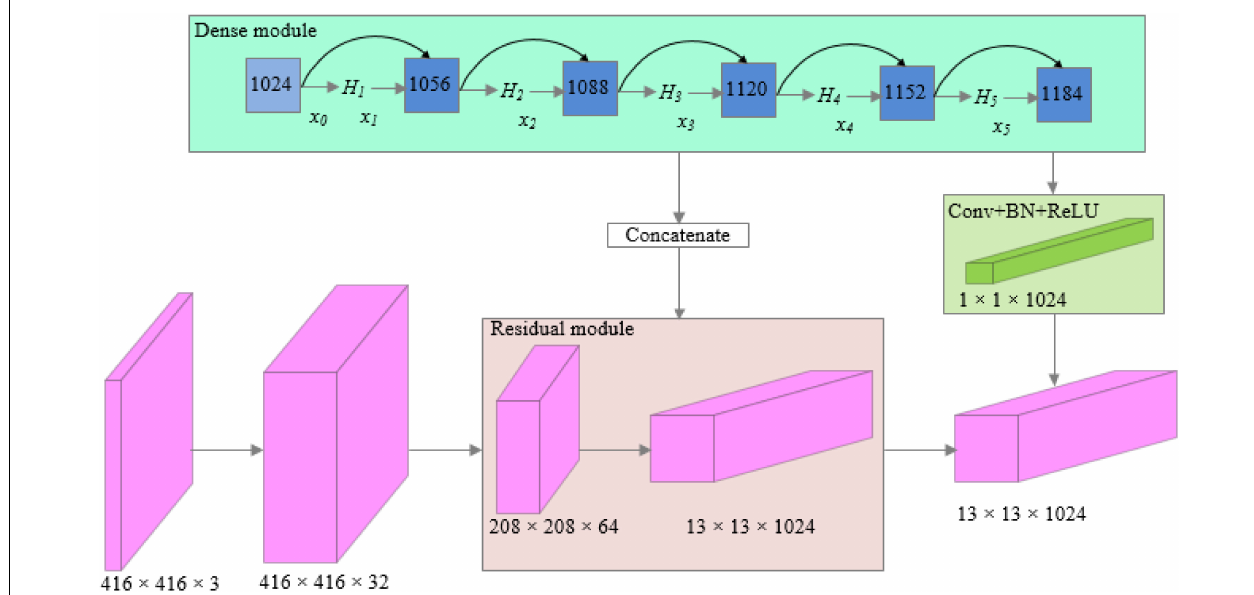
FIGURE 4 | Structure of dense modules of the YOLO-Dense network.